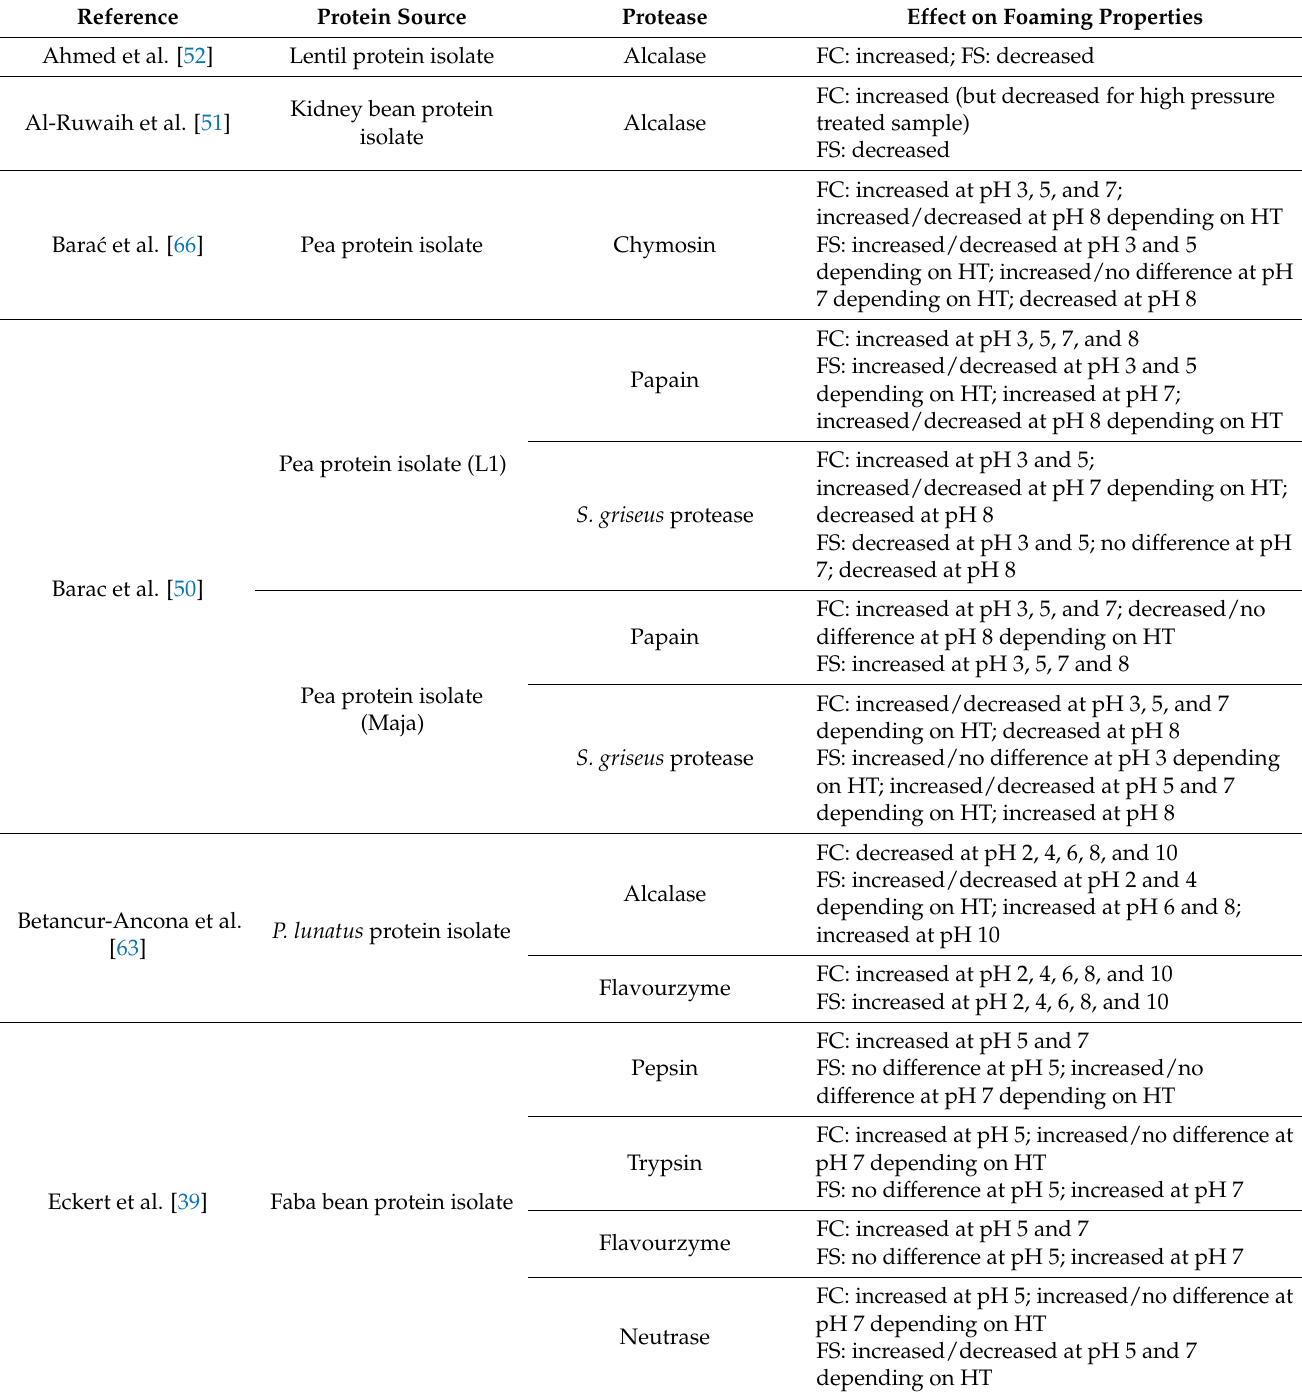
Table 4. Overview of the effects of enzymatic hydrolysis on foaming properties from various protein sources and